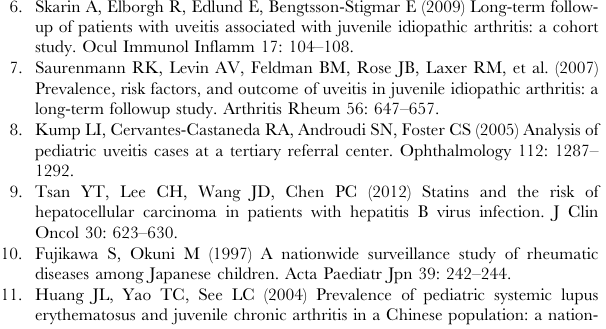
Table S5 Risk factors for uveitis in patients with